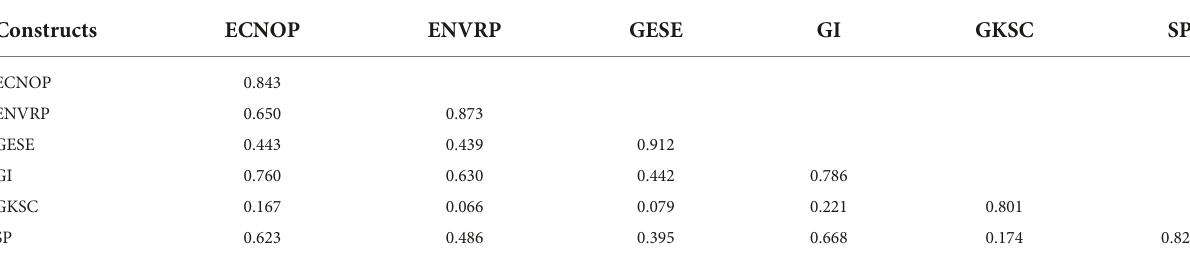
FIGURE2 Path model.